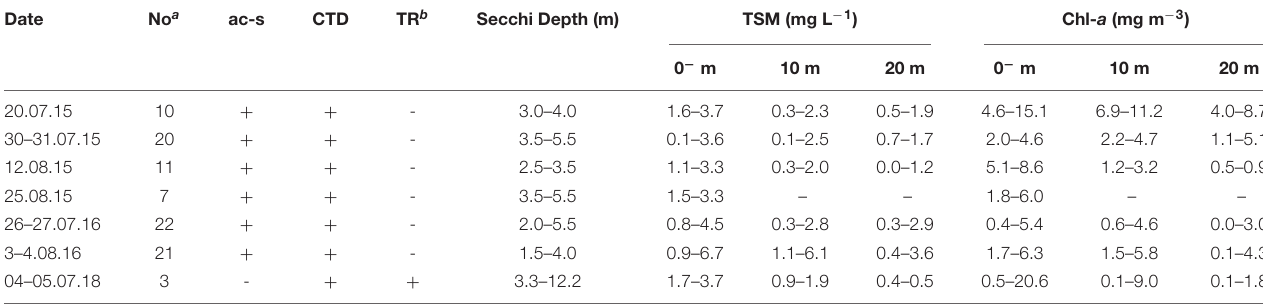
TABLE 1 | A summary of in situ measurements per study area